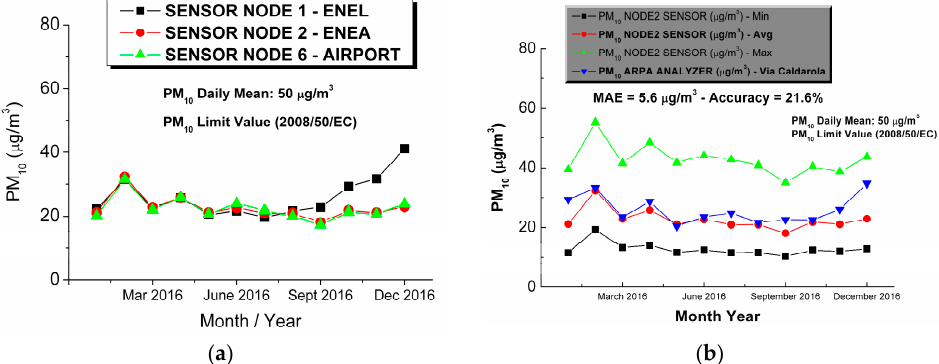
Figure 3. ( a ) Trend of the PM 10 monthly mean (January–December 2016) measured in the Node 1 (ENEL), Node 2 (ENEA) and Node 6 (Airport) by AIRBOX sensors deployed at Bari (Italy) for air quality monitoring; ( b ) Trend of the PM 10 monthly mean (January–December 2016) measured in the Node 2 (ENEA) by AIRBOX sensor (PPD20V, Shinyei) compared to the official reference data of the air quality monitoring station (Via Caldarola) in Bari (Italy) managed by ARPA-Puglia. Table 1. MAE and accuracy of the PM 10 AIRBOX Node 1 (ENEL), Node 2 (ENEA) and Node 6 (AIRPORT) of the ENEA WSN compared to the official reference data published by ARPA-Puglia. Node 1 Node 2 Node